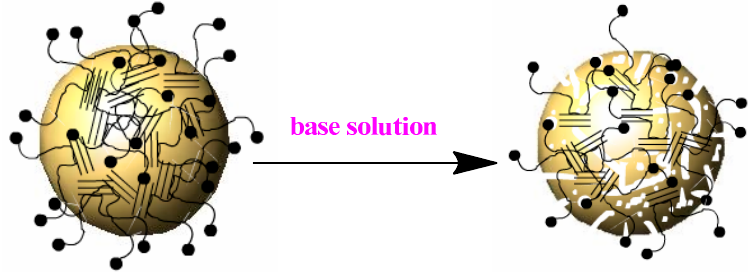
Figure 6. The ideal decomposed process of catalyst 1. Zirconium phosphates (phosphonates); Chloromethyl poly (styrene-phenylvinylphosphonate); ● Mn III (salen).